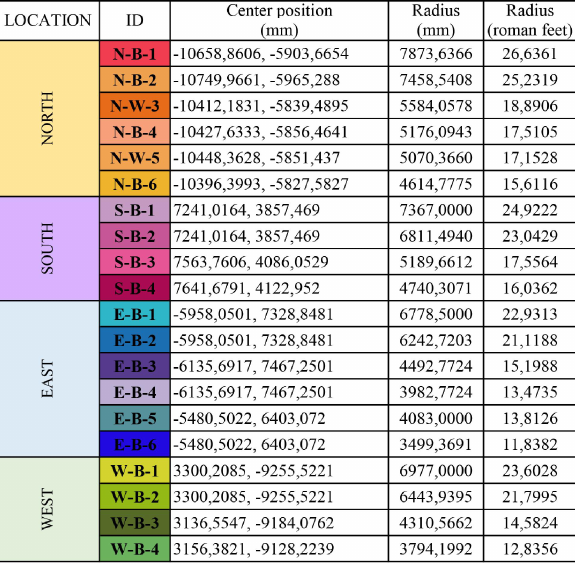
Table 6. Table with values for the analysed